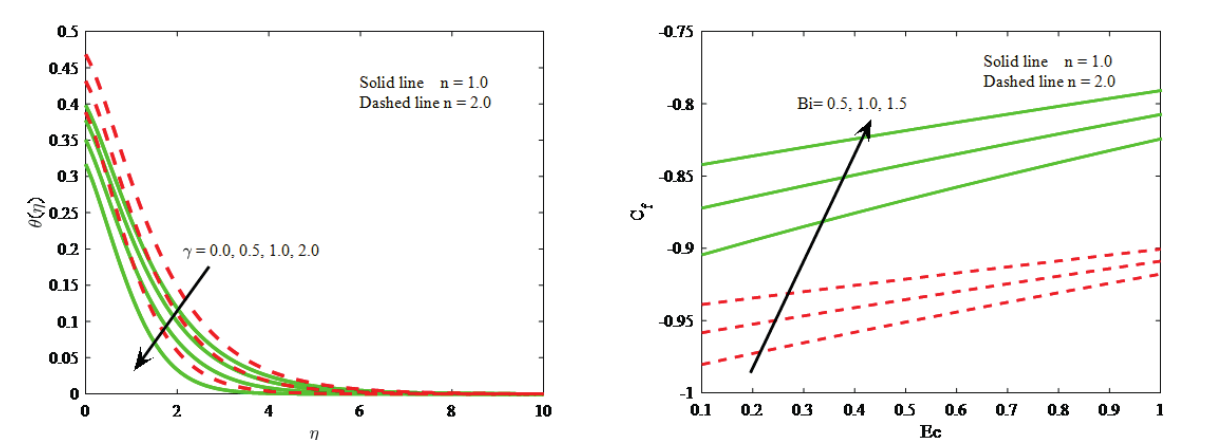
Fig. 13: Impact of γ on temperature.